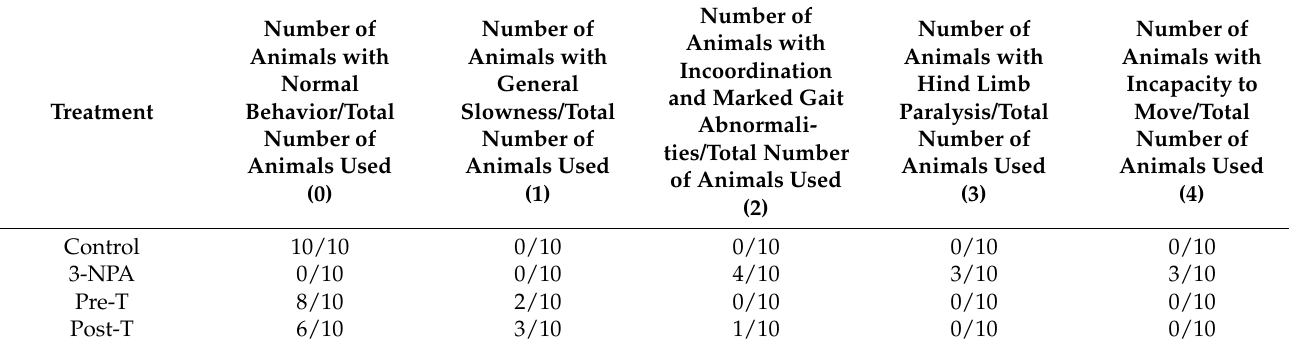
Table 1. Effect of C 60 pre- and post-treatment on movement analysis in rats subjected to 3-NPA.